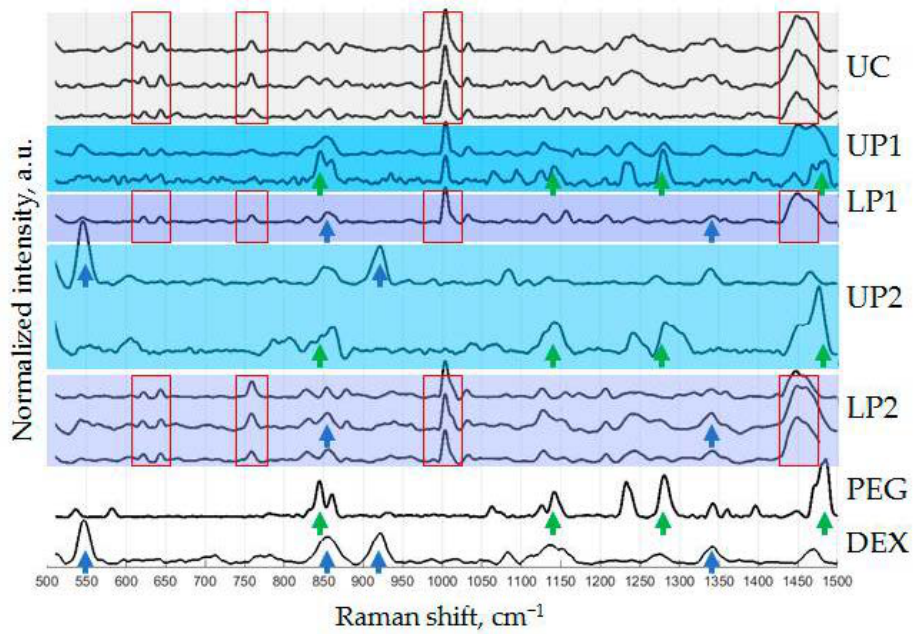
Figure 5. Raman spectra of PTPS phases and pure components. Measurements were repeated for samples that were supposed to be not homogeneous enough—these results are shown by multiple